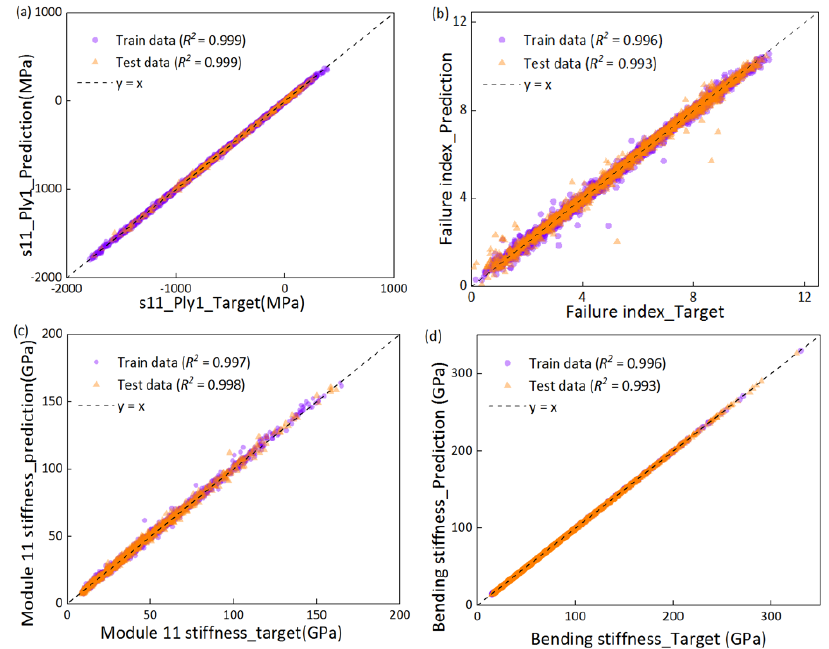
Figure 3. The regression performance for four networks in the proposed ML model. Models were trained with 2700 training data. ( a ) Network 1 for predicting the in-ply stresses S11 in four angled ply from the layup sequences. ( b ) Network 2 for predicting the Hashin fiber failure index from the in-ply stresses. ( c ) Network 3 for predicting the laminate modulus from four angle sequences and a single-layer board modulus. ( d ) Network 4 for predicting the stiffness from the laminate modulus.